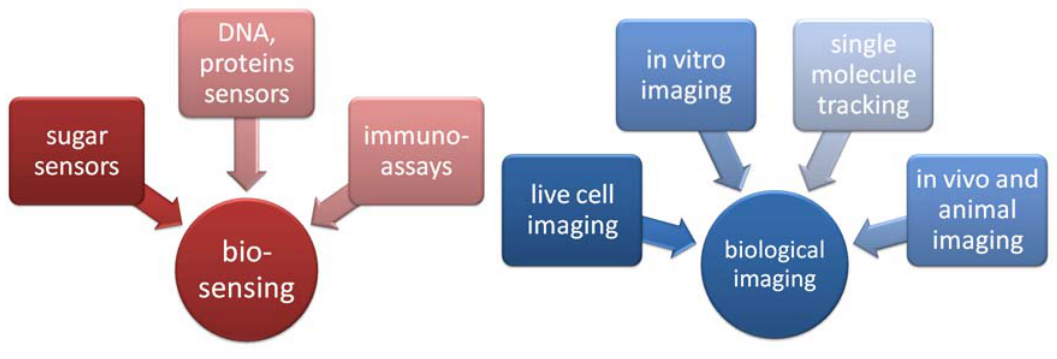
Figure 1. Examples of QDs’ bioanalytical and biomedical